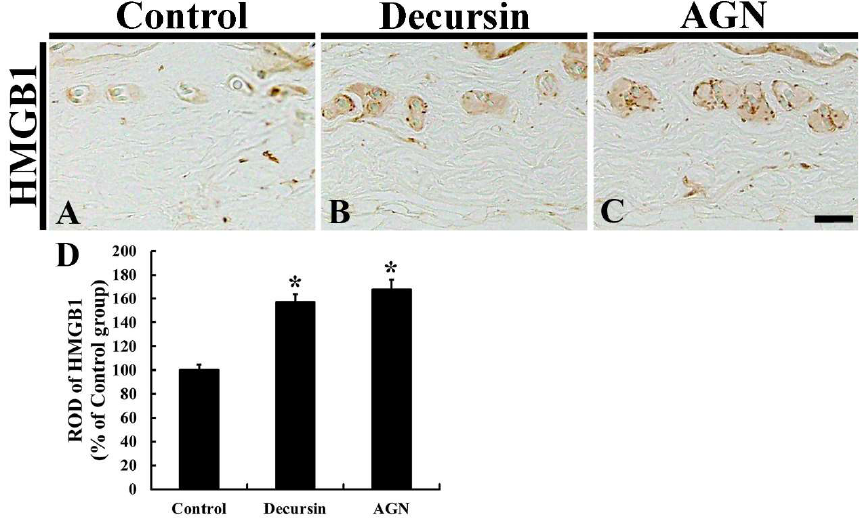
Figure 7. Immunohistochemistry for HMGB1 in the dorsal skin of the control ( A ), decursin ( B ) and AGN ( C ) groups at 17 days. In the decursin and AGN groups, significantly strengthened HMGB1 immunoreactivity is detected compared to that in the control group. Scale bar = 40 μm. ( D ) ROD of HMGB1 ( n = 10 in each group; * p < 0.05 versus control group). The bars indicate the means ± SEM.